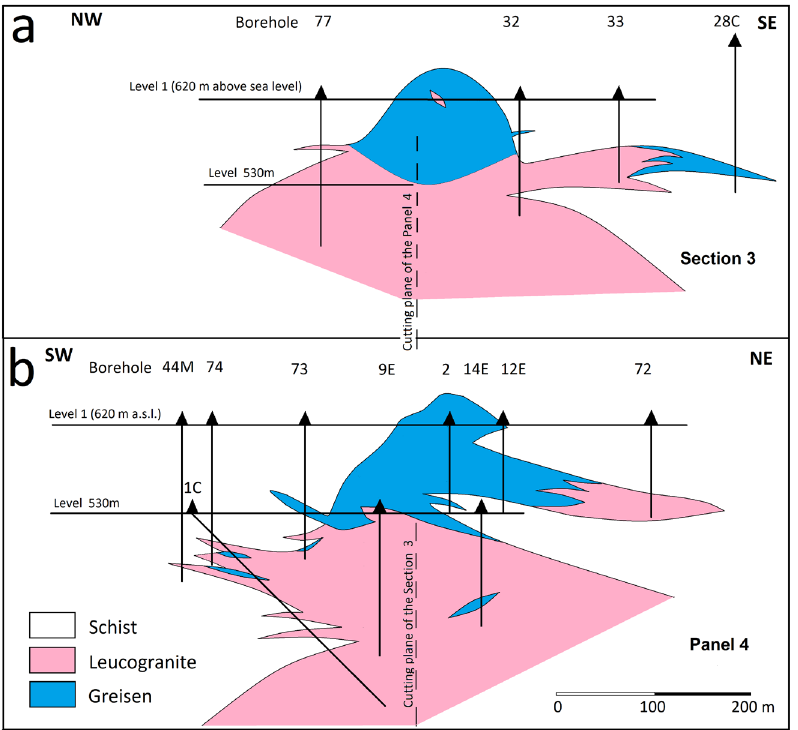
Figure 14. A cross-section through the Panasqueira hidden granite cupola according to re-evaluation of borehole cores: ( a ) NW–SE section along “Section 3”; ( b ) SW–NE section along “Panel 4”.